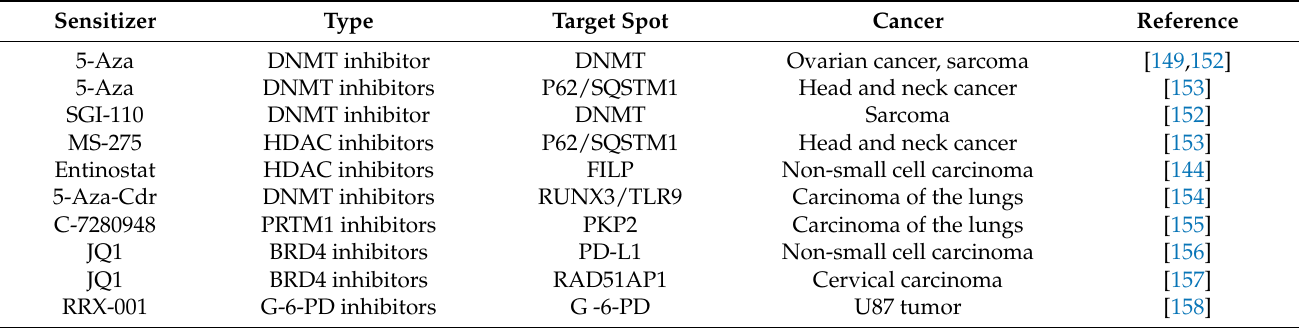
The full name represented by the abbreviation in the Table 2: 5-Aza: 5-Aza-2’-deoxycytidine (Decitabine); SGI-110: Guadecitabine; MS-275: Entinostat (MS-275); 5-Aza-Cdr: 5-Aza-2’-deoxycytidine (Decitabine);